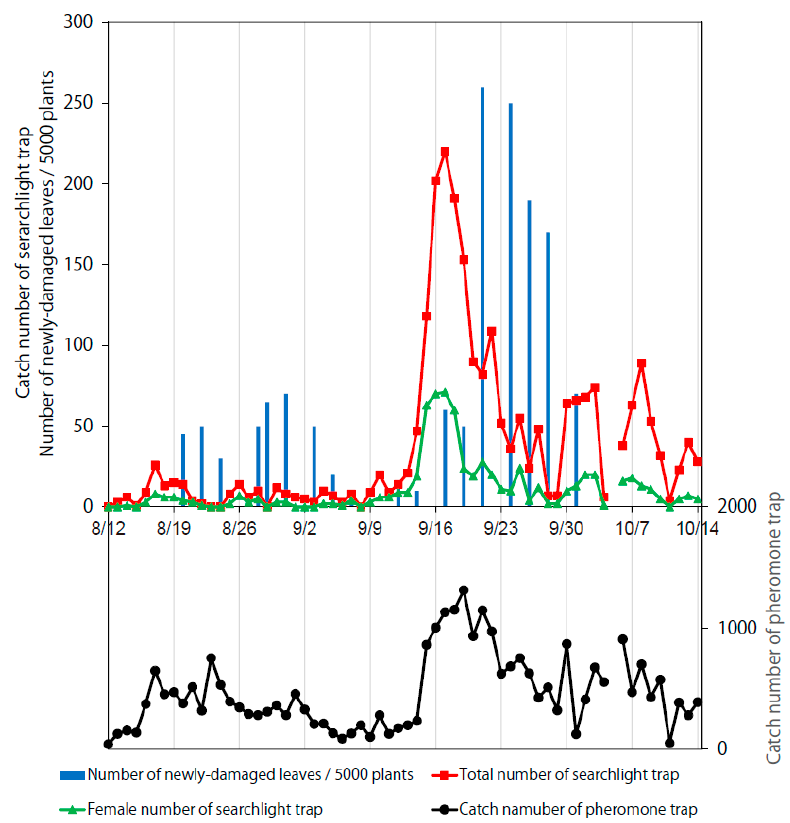
Figure 4. Temporal variation of S. litura catch numbers caught by the searchlight and pheromone traps, and the numbers of newly damaged leaves per 5000 soybean plants in 2018.